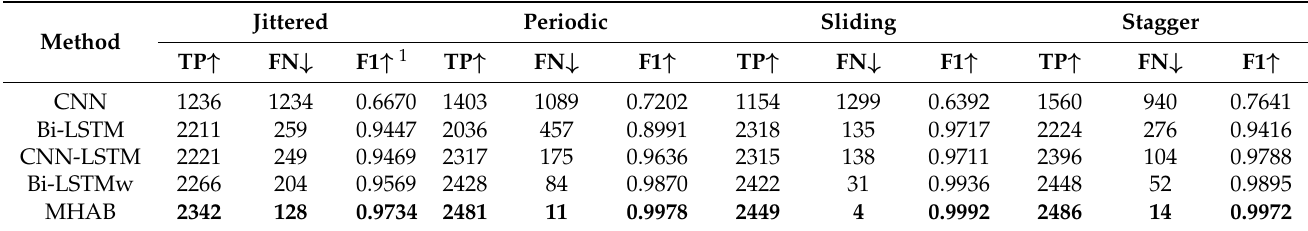
Table 3. Effectiveness of four modulation types.